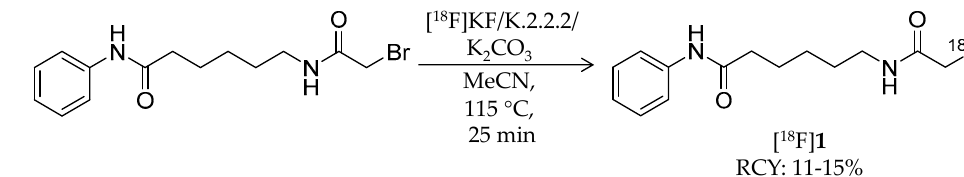
Scheme 1. Radiosynthesis of [ 18 F] 1 .